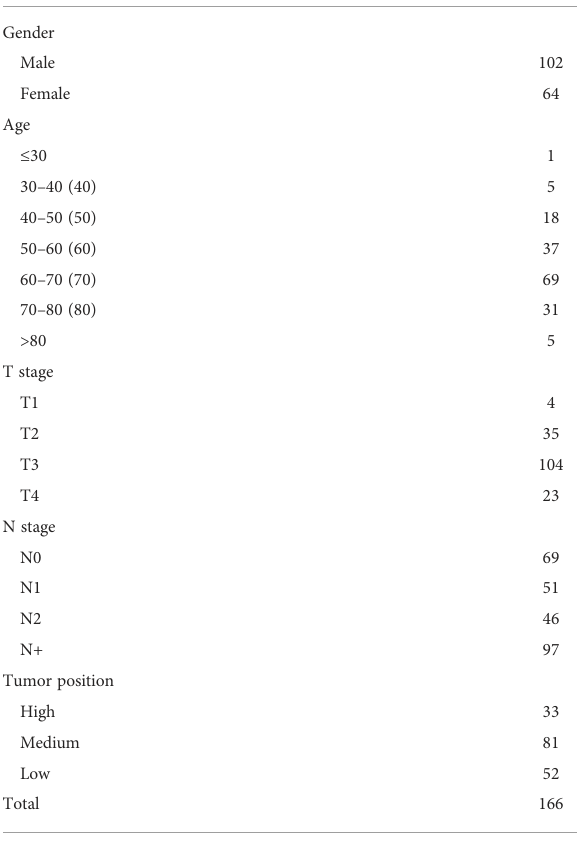
TABLE 2 Clinicopathological parameters of 166 patients. Clinicopathological